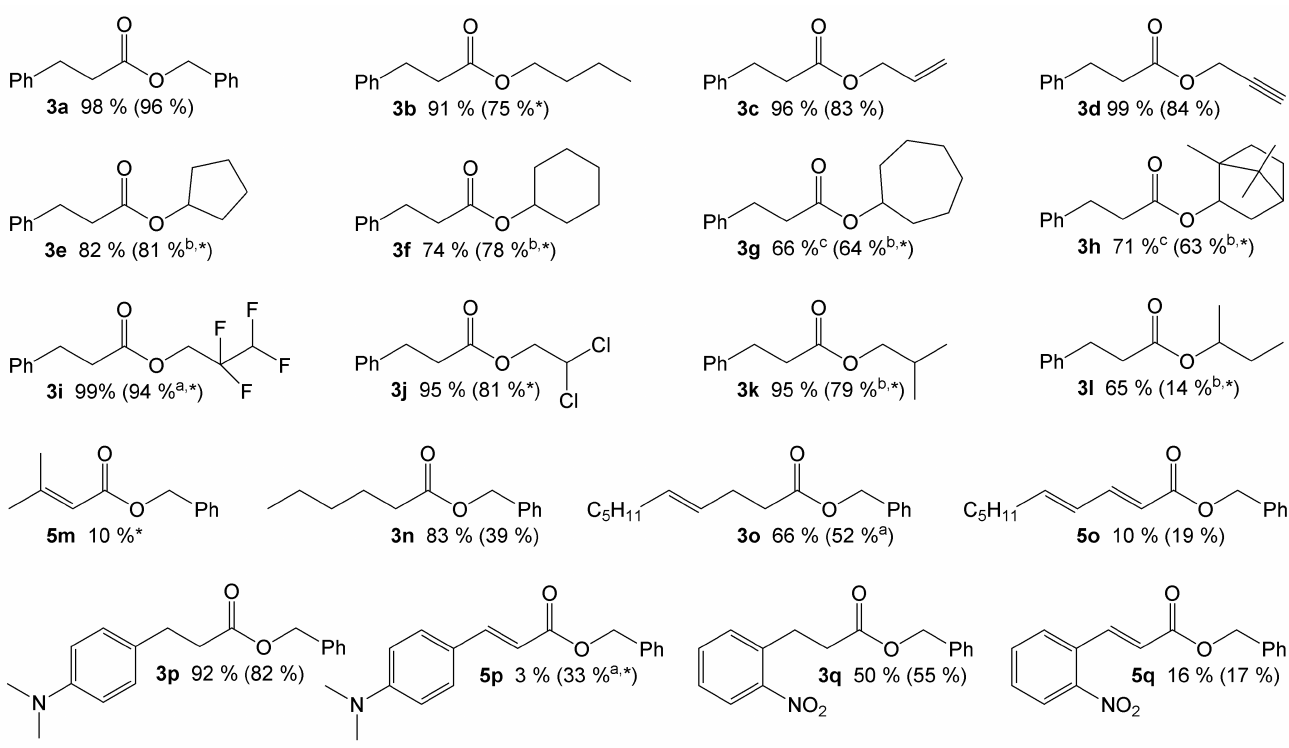
Figure 2. Structures of products obtained from the substrate screening and the highest GC yields achieved with model and dendritic (in parentheses) catalysts ( G 0 DippImI and G 1 (DippImI) 4 , respectively, unless otherwise